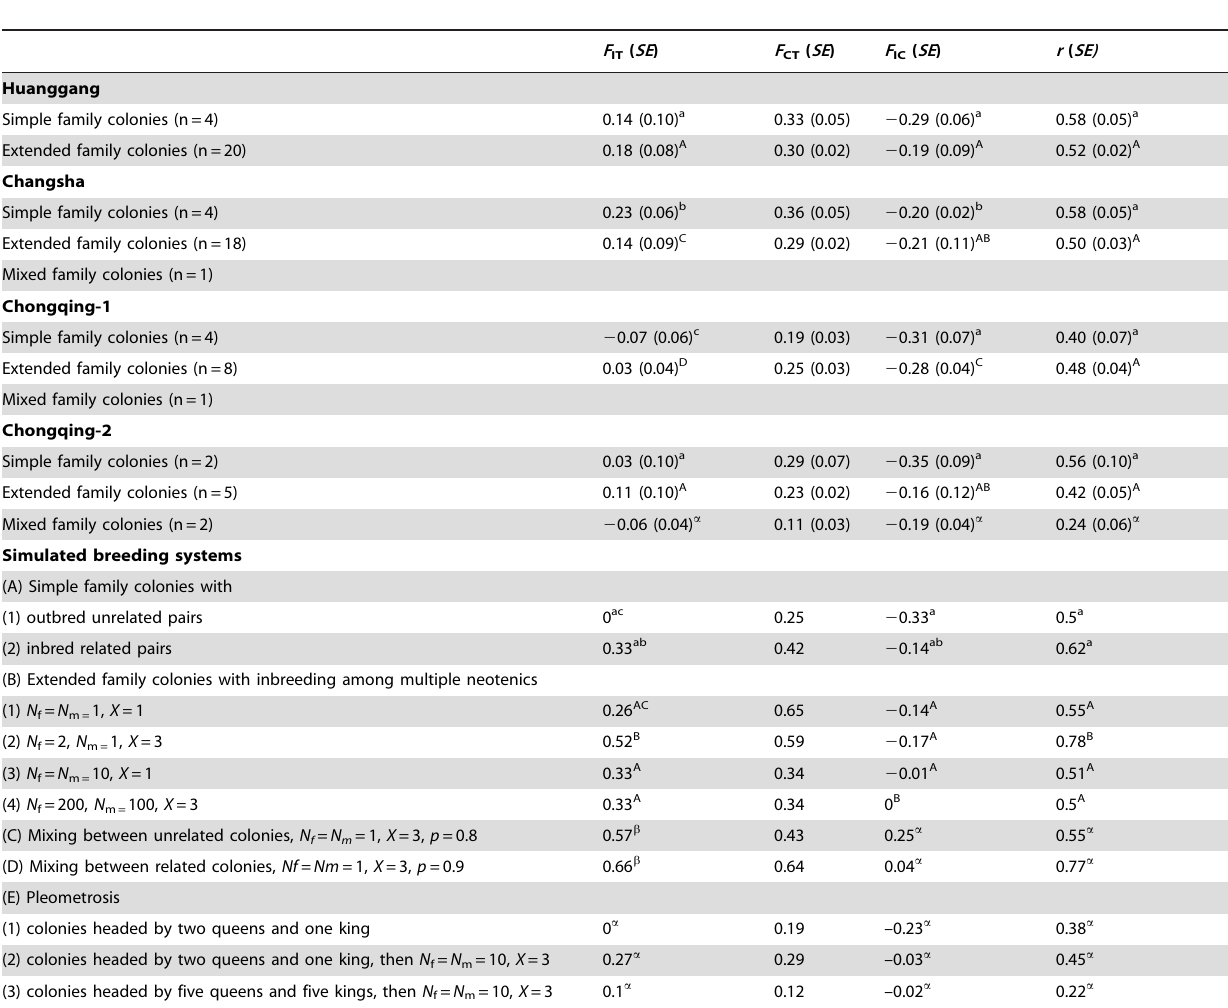
Table 2. F -statistics and relatedness coefficients for workers from R. chinensis colonies from four populations in China and expected for possible breeding systems of subterranean termite colonies previously derived from computer simulations [20,21].